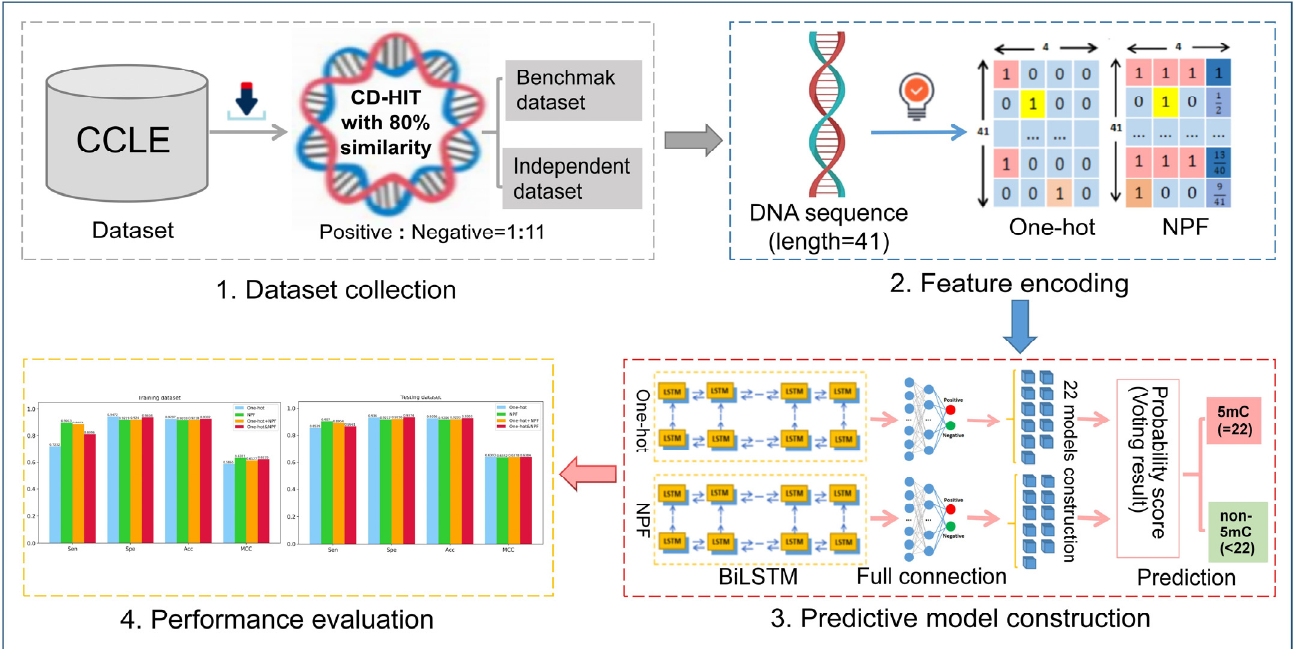
Figure 1. The workflow of the proposed BiLSTM-5mC model for the prediction of 5mC sites.